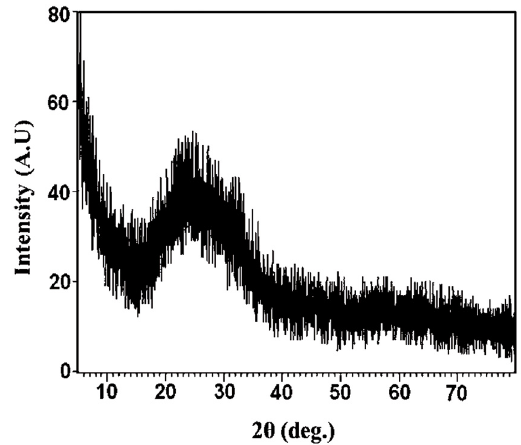
O film with 2 3